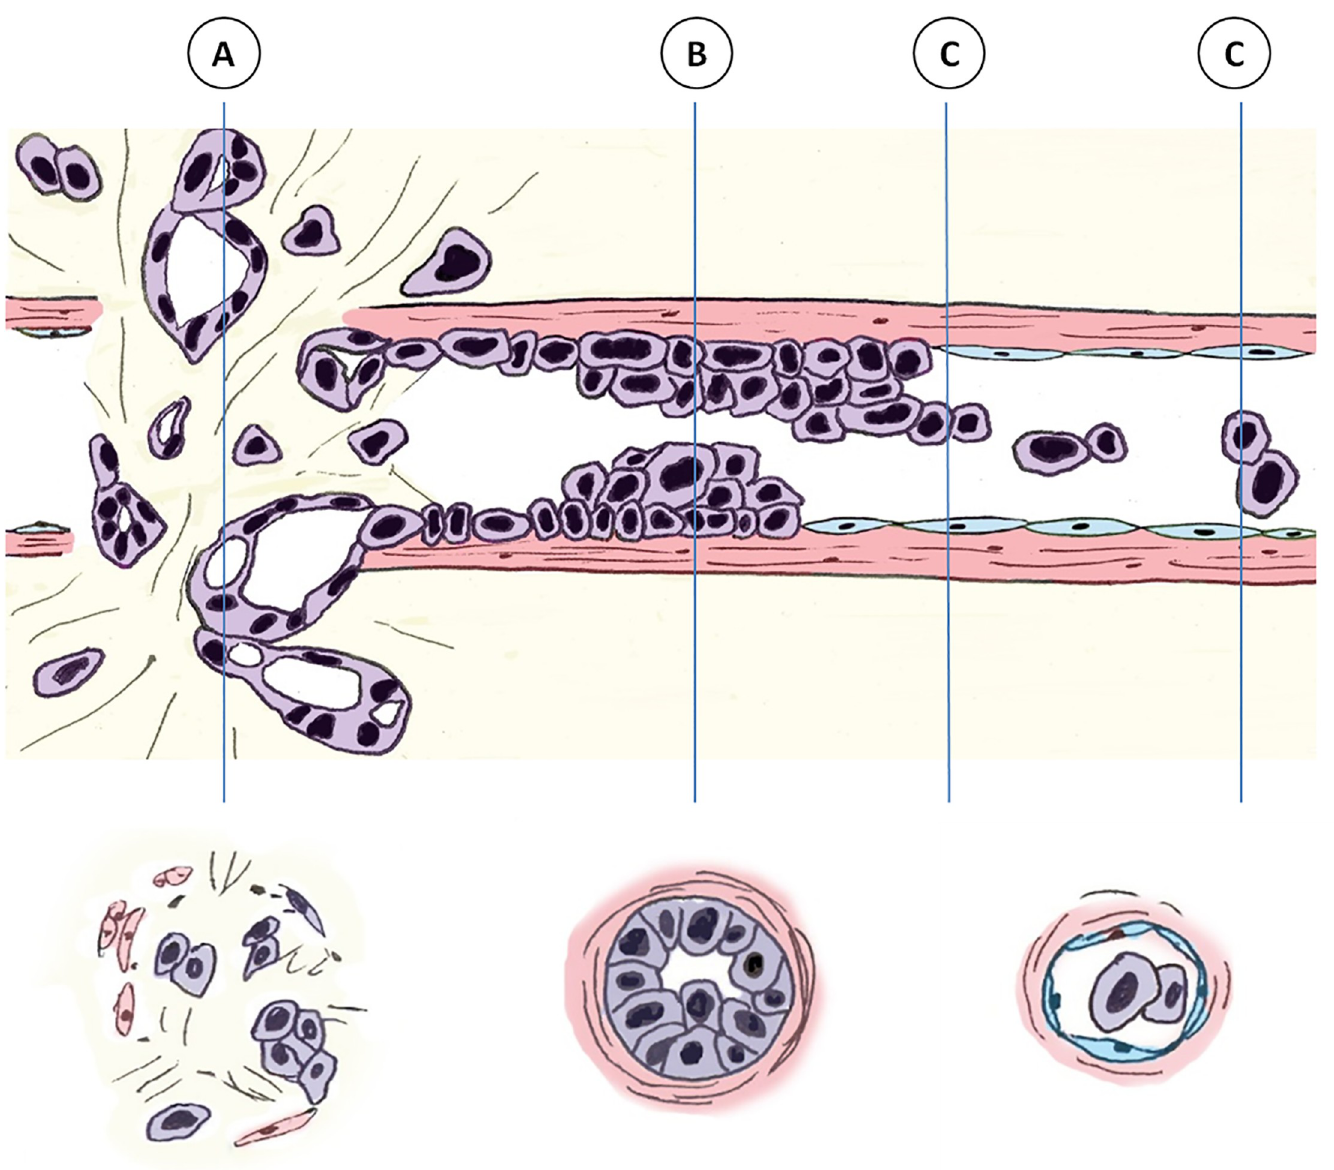
Fig 9. Diagram showing the proposed sequence of VI of pancreatobiliary tract